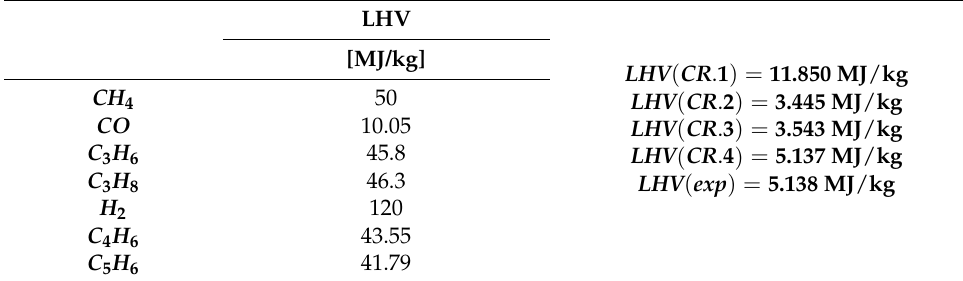
Table 9. Syngas combustible species and reference LHV values adopted for the LHV